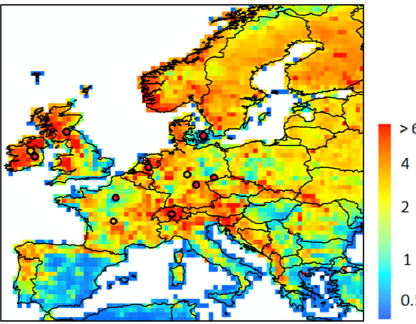
Figure 7. Modeled yearly mean terrestrial DOC leaching flux (period 1979–2006) to the river European river network (in gCm − 2 yr − 1 ). The local observations from Kindler et al. (2011) are also reported, using the same scale. Note that the local observa- tions cover a much shorter time period and may not be representa- tive of the whole year.